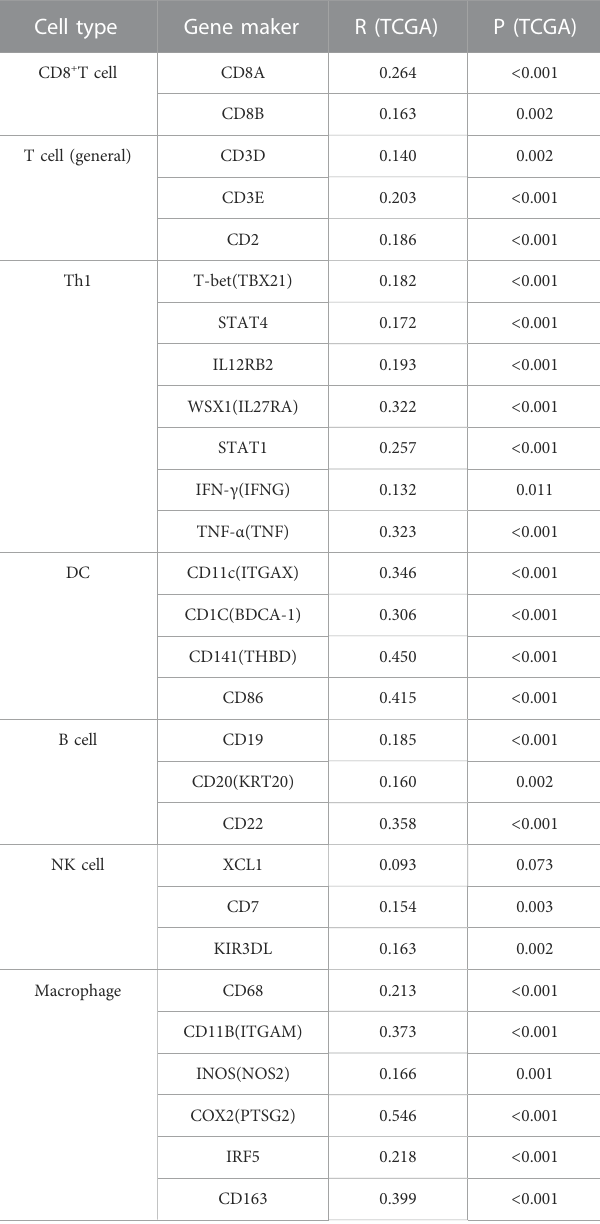
TABLE 3 The correlations between KLF4 and gene markers of immune cells in